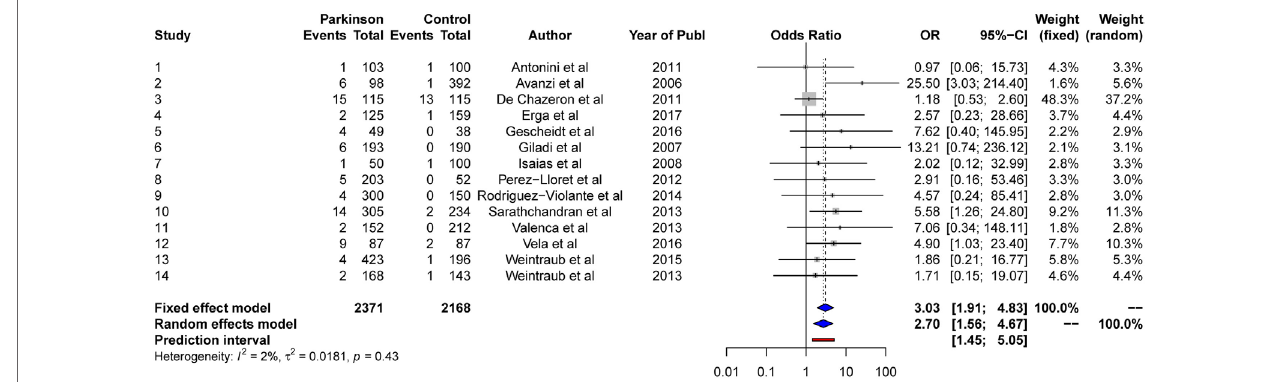
FigURe 4 | Forest plot of